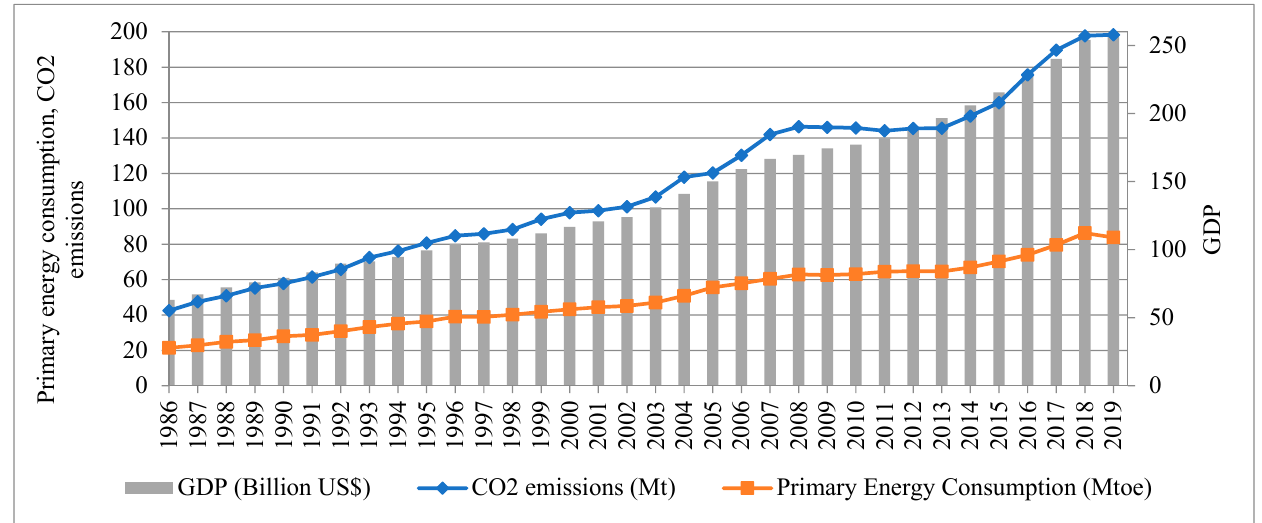
Figure 1. Primary energy consumption, CO 2 Es, and gross domestic production in Pakistan (1986–2019). Source: Pakistan Energy Yearbook [8]; Pakistan Economic Survey [10]; World Bank [7].